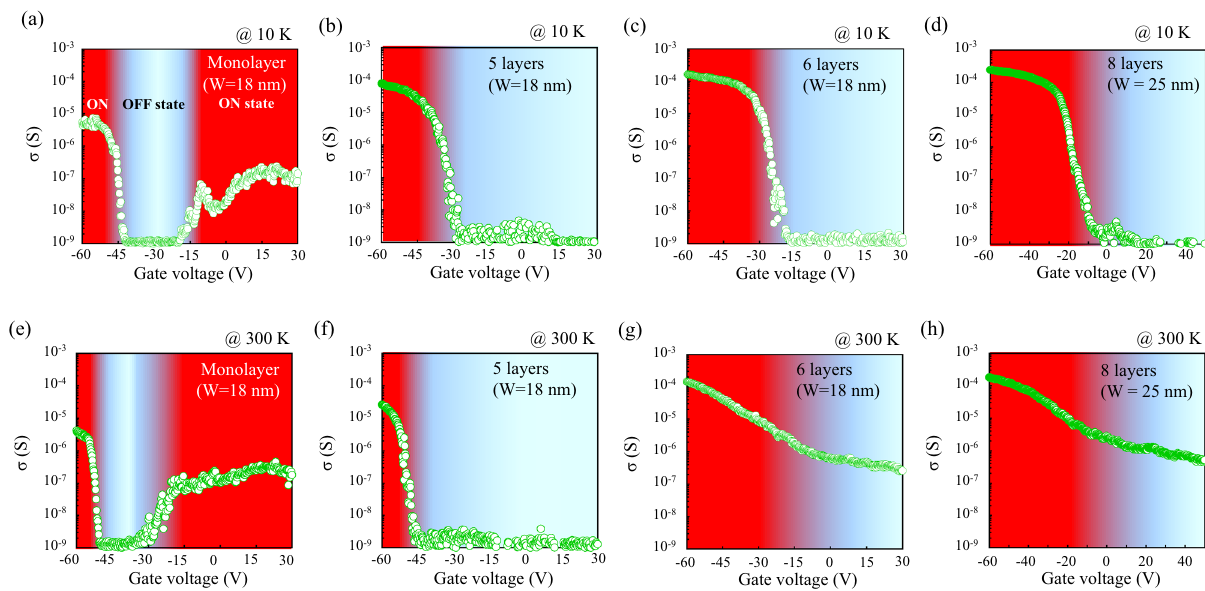
Figure 3. Transfer characteristics in the ( a , e ) monolayer and ( b – d , f – h ) grown multilayer GNR-FETs measured at 10 K and 300 K,